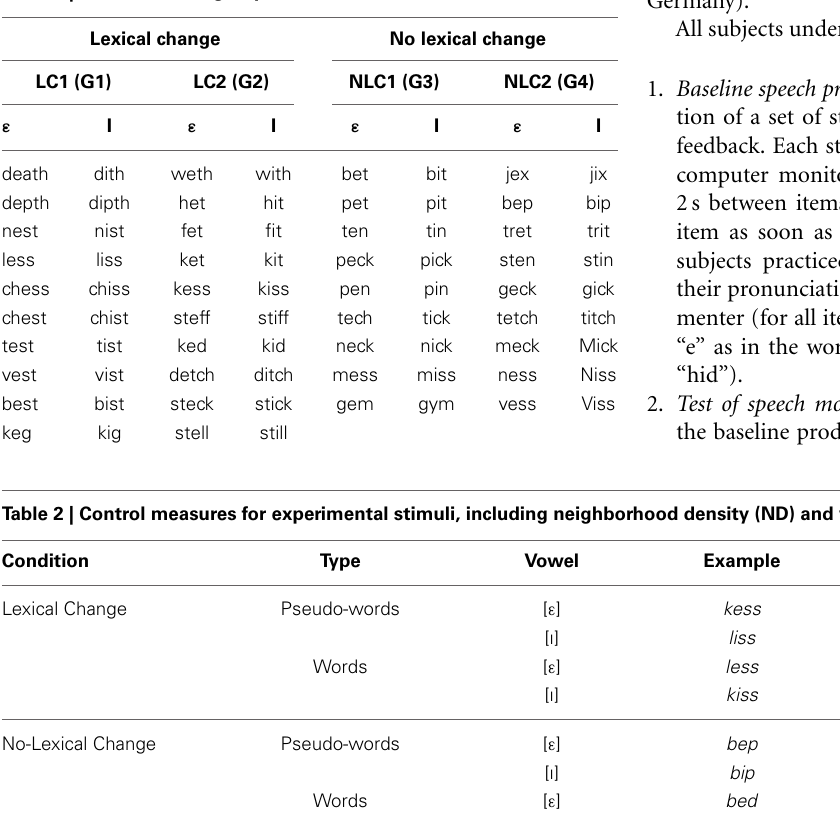
Table 1 | Distribution of groups as a function of condition.